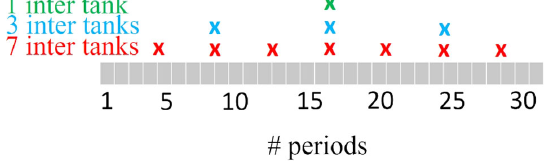
FIG. 8. Sketch of the prolonged beam line comprising 31 complete DTL periods. The locations of intercavity sections for the various scenarios are indicated.